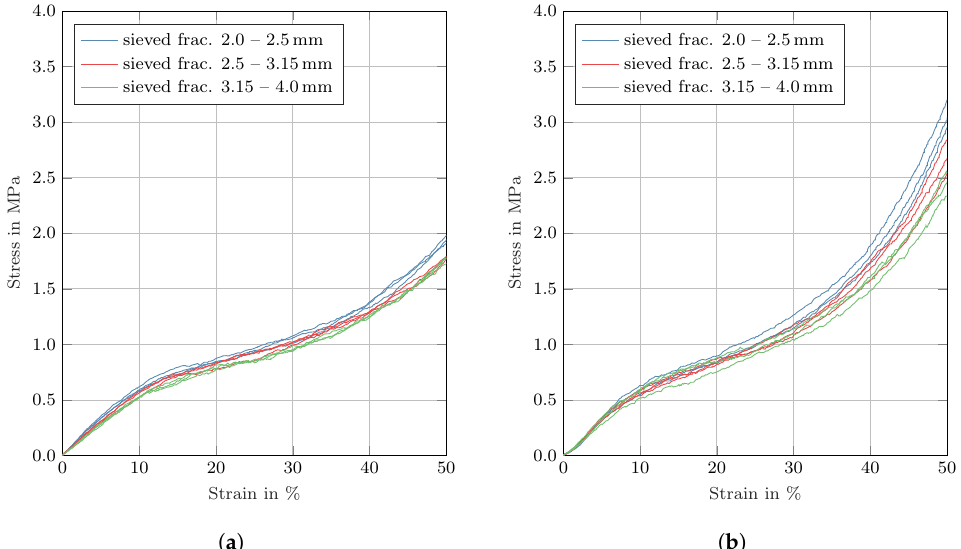
Figure 11. Stress–strain curves for multi-particle compression test of sieved particles of uncoated and Candelilla wax-coated Poraver ® particles. ( a ) Poraver ® —Pure. ( b ) Poraver ® —Candelilla